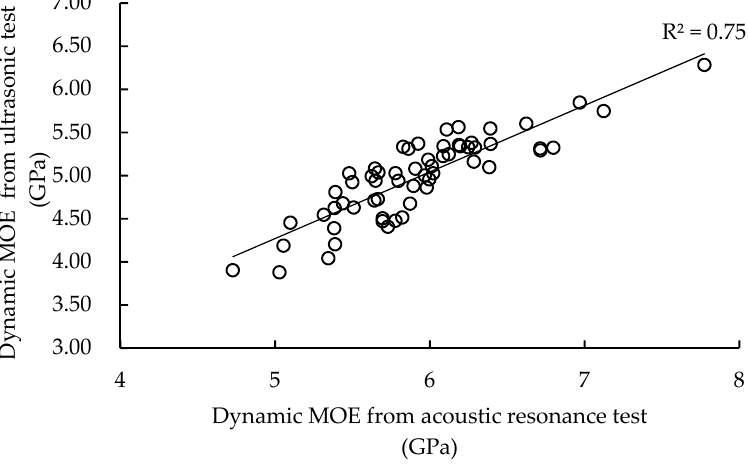
Figure 13. Relationship between dynamic MOE values from ultrasonic and acoustic resonance tests.